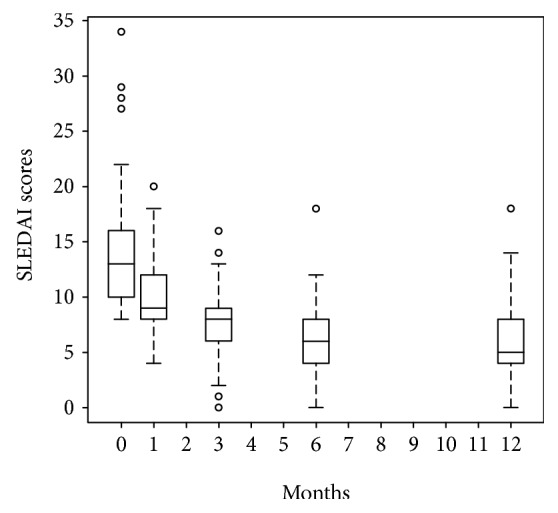
Improvement of the SLEDAI score during the 12 months following allogeneic BM/UC-MSC treatment (p < 0.001). During the year after allogeneic BM/UC-MSC injection, the SLEDAI score improved significantly (p < 0.001) over time with median values of 9 (4–20), 8 (0-16), 6 (0-18), and 5 (0-18) at 1, 3, 6, and 12 months, respectively, as compared to baseline 13 (8-34).